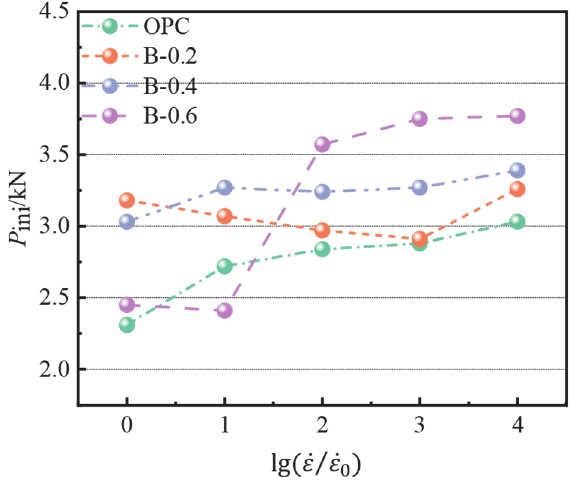
Figure 9. Relationship between the initial cracking load and strain rate.